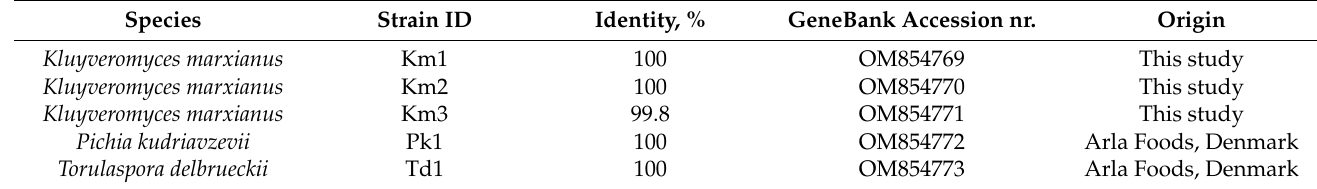
Table 1. Yeasts in this study identified by 26S rRNA gene